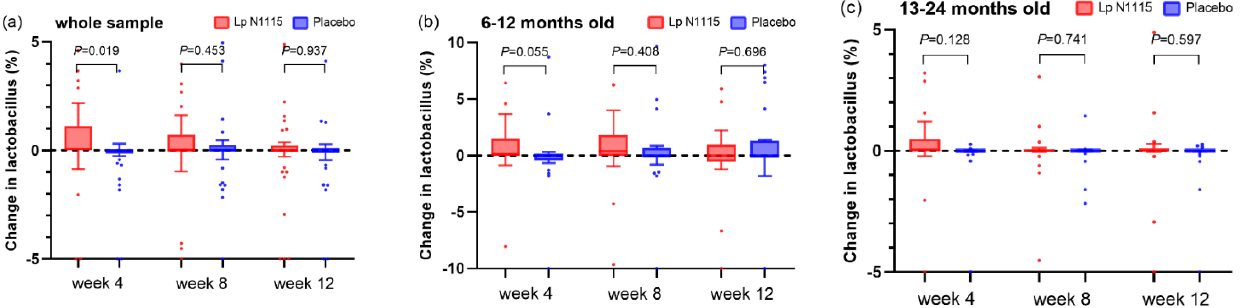
Figure 6. Changes in the relative abundance of Lactobacillus compared with baseline. ( a ) relative abundance of Lactobacillus changes of all participants; ( b ) relative abundance of Lactobacillus changes of 6–12-month-old subgroup; ( c ) relative abundance of Lactobacillus changes of 13–24-month-old subgroup.